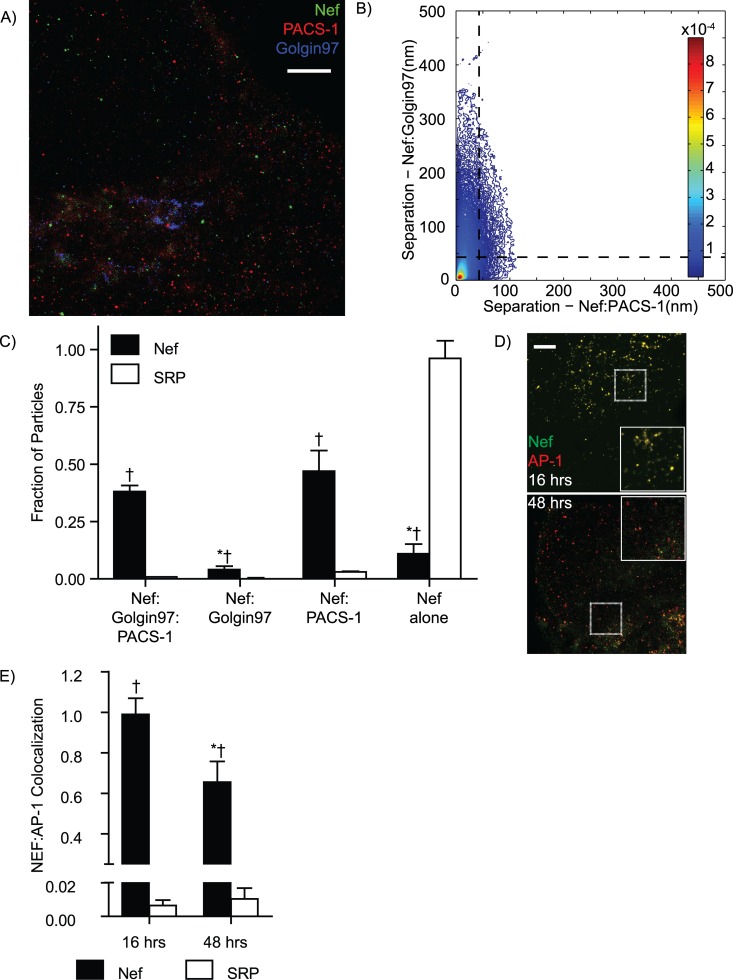
Quantification of intermolecular interactions between Nef, PACS-1, AP-1 and the Golgi, using Spatial Association Analysis.(A) Representative image of GFP-Nef, PACS-1-mCherry and Golgin97 staining in a CD4+ HeLa cell 48 hours post-transfection. (B) SAA histogram of panel A, plotting the distance between each Nef molecule and the nearest PACS-1 and nearest Golgin97. Horizontal and vertical dotted lines indicate the CDC below which molecules are potentially colocalized. (C) Quantification of Nef colocalization patterns with Golgin97 and PACS-1, with the fraction of Nef colocalized with both Golgin97 and PACS-1, associated with either Golgin97 or PACS-1, or not colocalized with either molecule indicated. (D) Images of and (E) quantification of AP-1 and Nef colocalization patterns during the endocytosis-targeting (16 hrs) and Golgi-targeting (48 hrs) phases of Nef activity. SRP = Simulated Random Positions. A,D are representative images of, and B,C,E quantify 3 experiments, 5 images per experiment. Data are presented as mean ± SEM, † = p < 0.05 compared to SRP, * p < 0.05 compared to NEF-Golgin97-PACS-1 (C) or 16 hrs (E). Scale bars 2.5 μm, inserts are 3.5 μm x 3.5 μm.